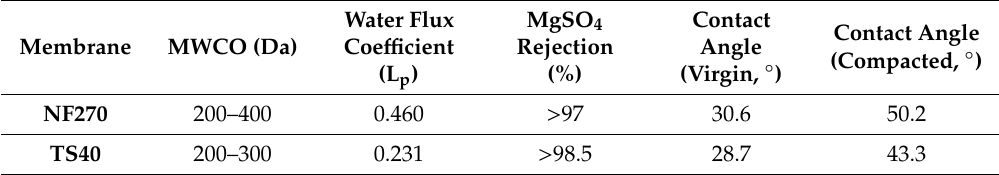
Table 1. Membrane operational